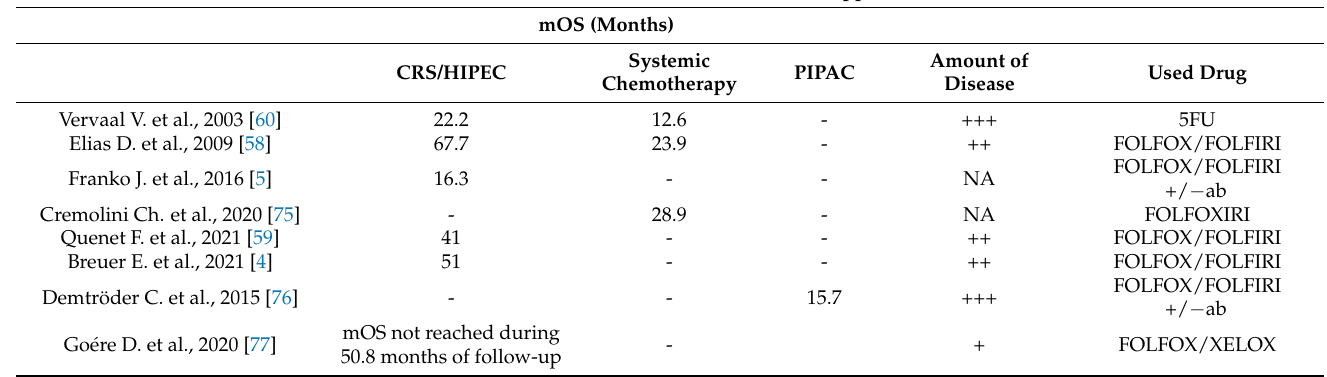
Table 1. Current data on the treatment of PM from CRC by either systemic therapy alone or in combination with locoregional treatment. It is critical to highlight that the amount of disease in the peritoneum or the chemotherapy regimen differed among the studies. (amount of disease: +++ extensive load of PM, ++ moderate load, + limited load, NA: not